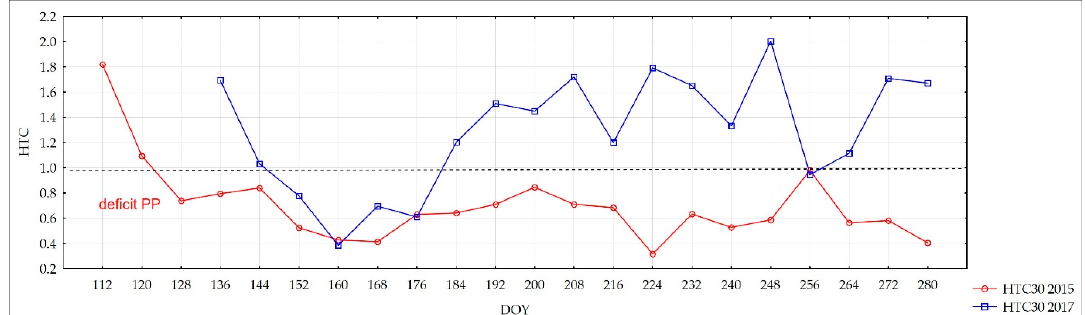
Figure 3. Changes in hydrothermal coefficient (HTC) for growing seasons 2015 and 2017—meteorological station Smolice.